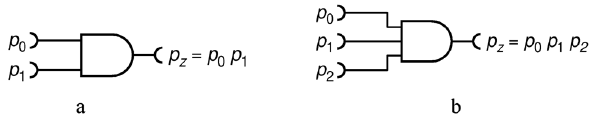
Figure 5. Circuits for exact multiplication of two numbers (a) ; and three numbers (b)